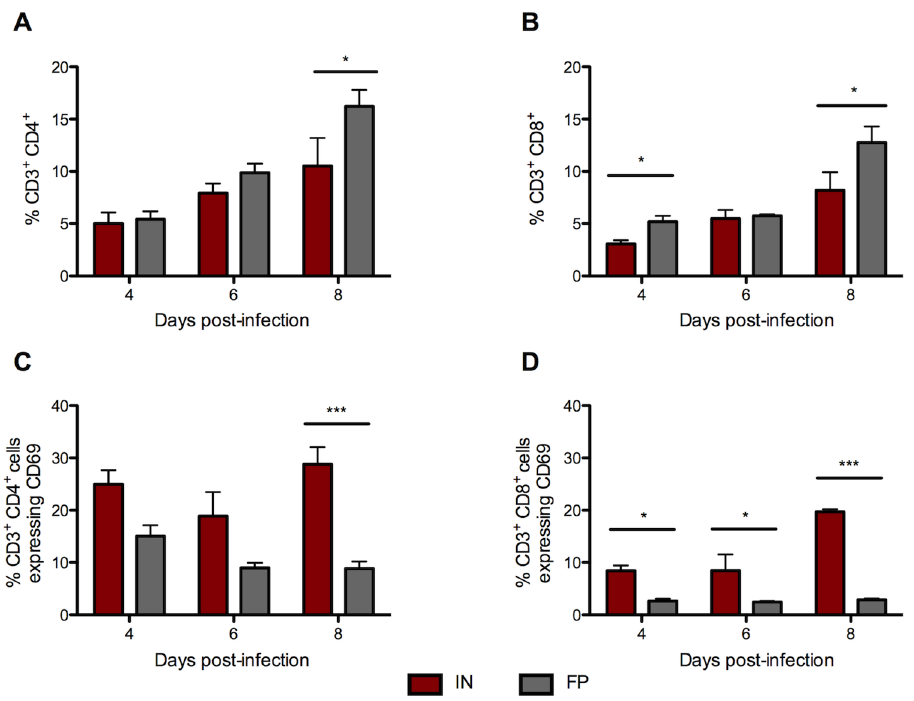
Figure 5. IN-inoculated mice have a significantly higher percentage of activated T cells in the spleen than FP-inoculated mice. Flow cytometry was used to determine the proportion of (A) CD3 + /CD4 + and (B) CD3 + /CD8 + T cells in the spleens of IN- and FP-inoculated mice. The proportion of T cells that stained positive for activation marker CD69 are shown in (C) CD3 + /CD4 + /CD69 + and (D) CD3 + /CD8 + /CD69 + .Averages based on groups of 3 mice per time